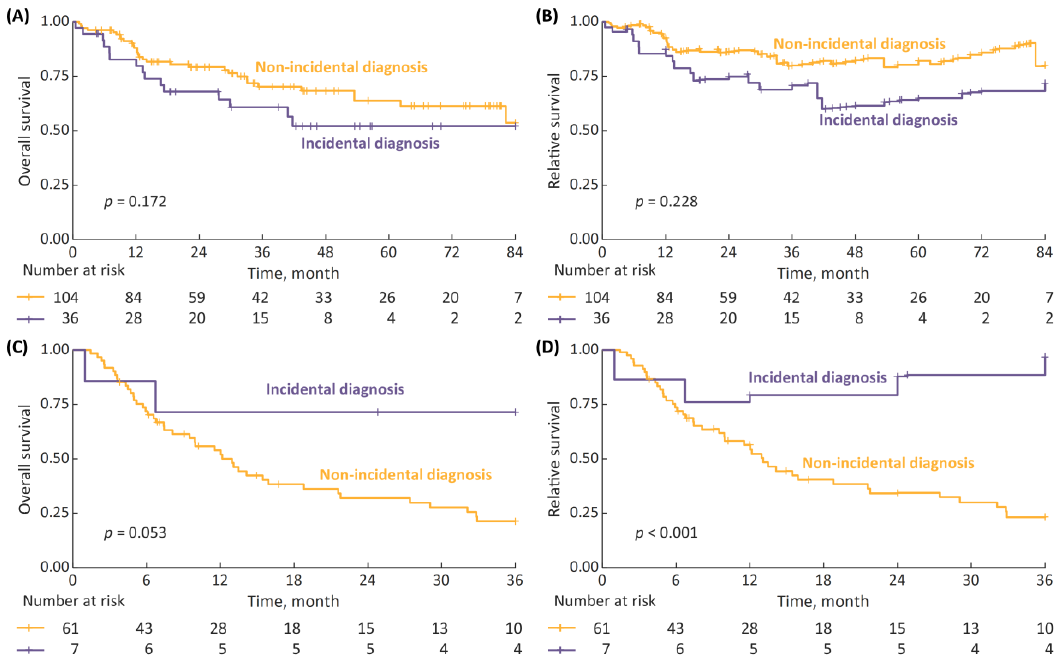
( B ) 7-year relative survival (RS); ( C ) 3-year OS in non-metastatic MIBC patients stratified by type of diagnosis; and ( D ) 7-year RS.